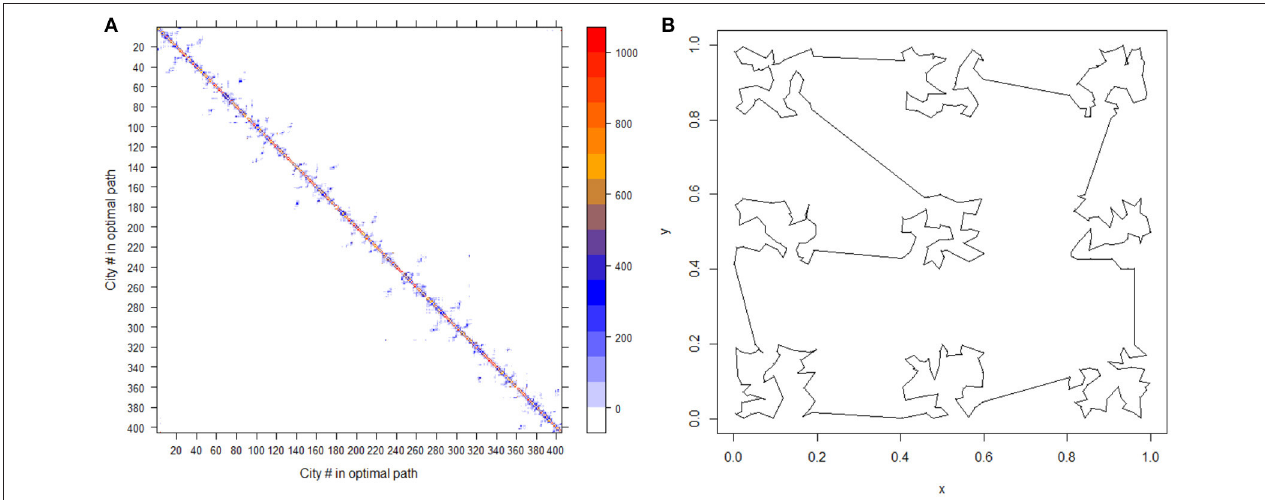
FIGURE 2 | An overall view of the ensemble of 1000 optimal TSP solutions (A) and the optimal TSP solution